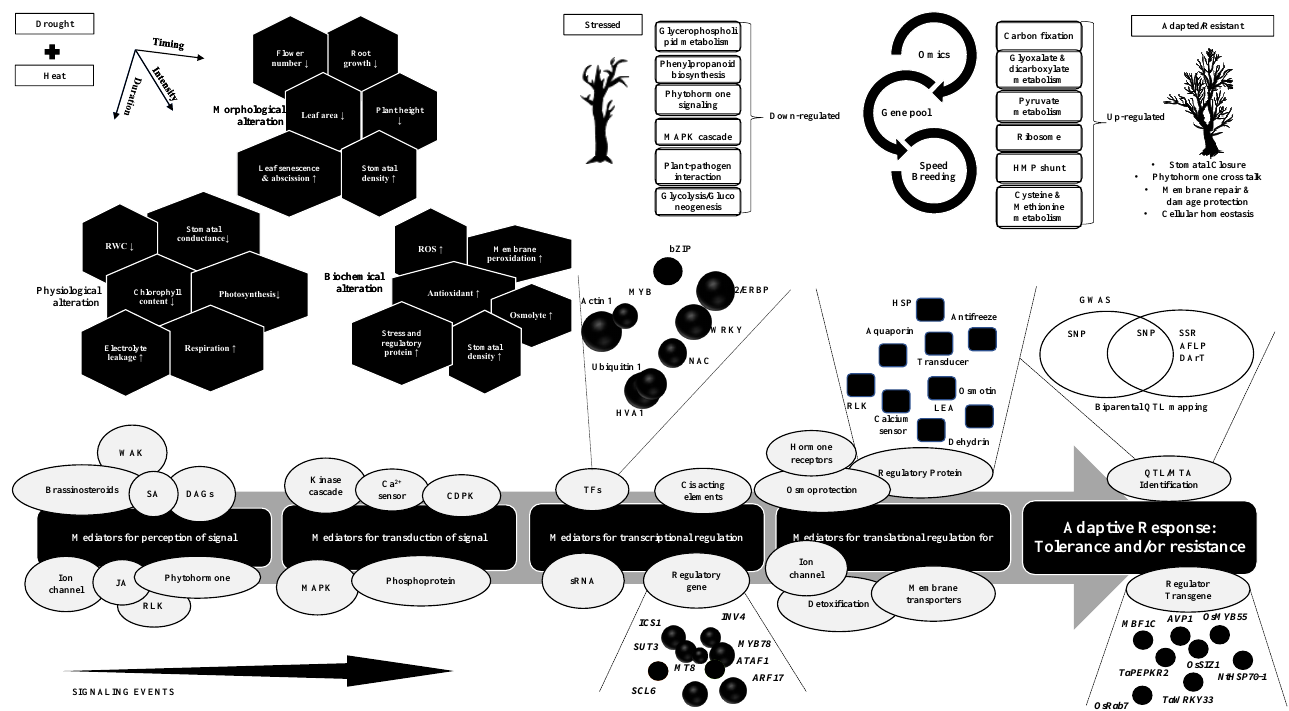
Figure 2. Schematic representation of the molecular mechanism for combined drought and heat stress endorsement in crop plants.